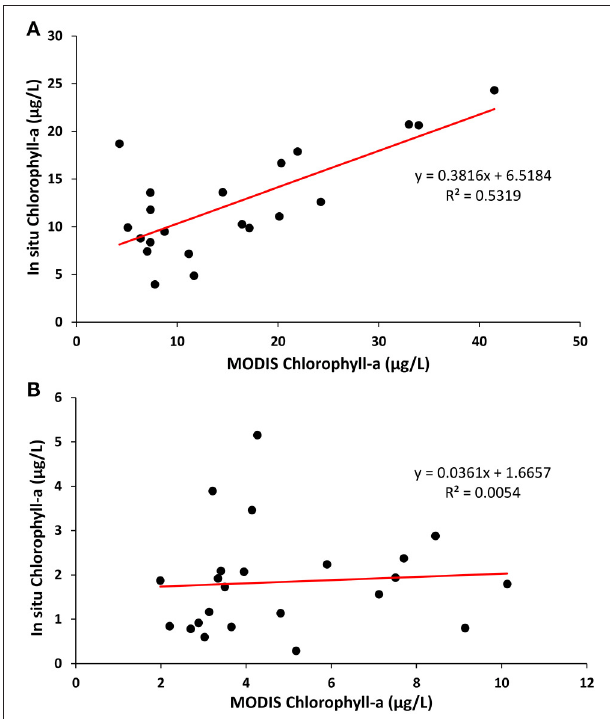
FIGURE 4 | Scatter plots showing the relationship between MODIS-retrieved chlorophyll- a with in situ measured chlorophyll- a at (A) Toledo and (B) Painesville water plant intake points from May to October, 2013. The solid lines represent the best-fit linear regression models.